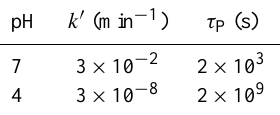
Table 2. Pseudo-first order rate constants, k 0 , and processing (reac- tion) timescales, τ P , for the oxidation of iron(II) under different pH conditions.